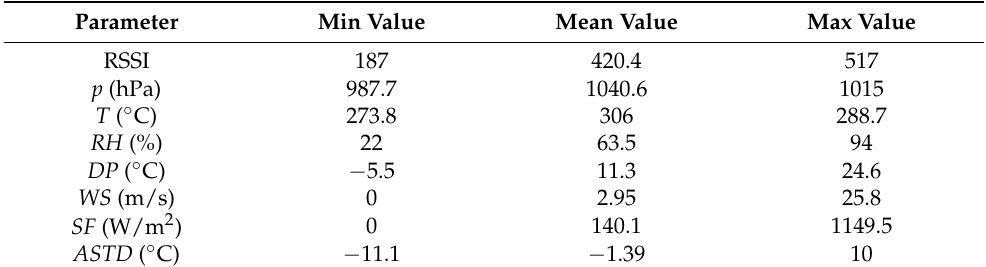
Table 1. The value range of the meteorological parameters for the period 30 November 2019 to 27